Question: State the chart type depicted above.
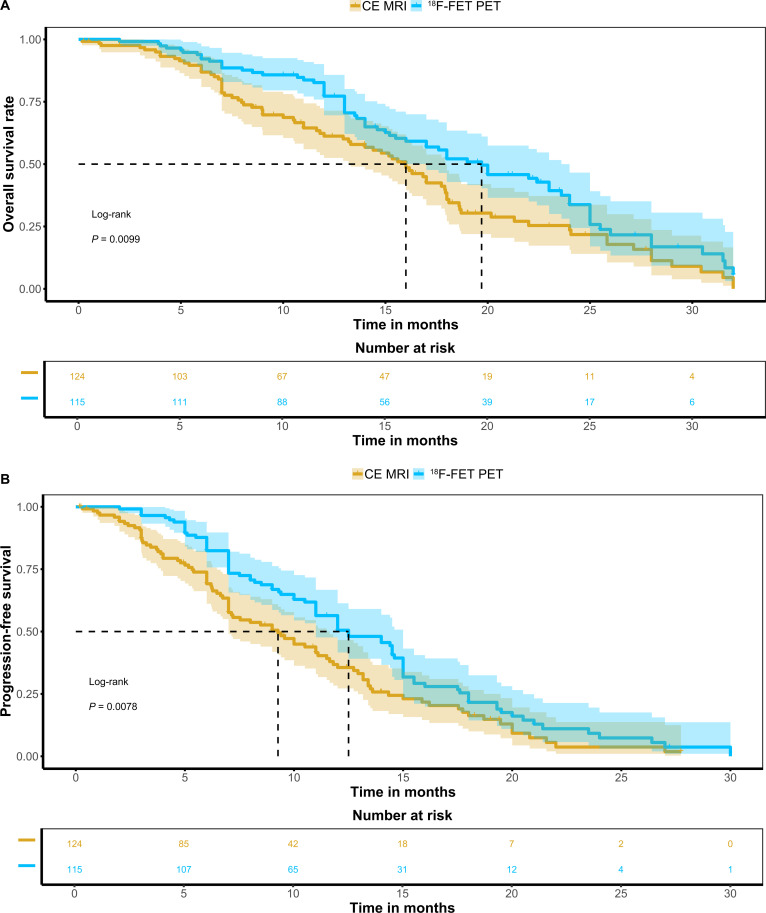
Answer: survival